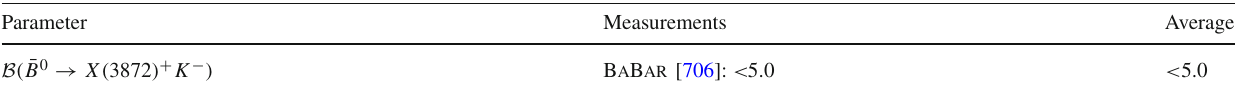
Table 132 Decays to charged states I [ 10 − 4 ]